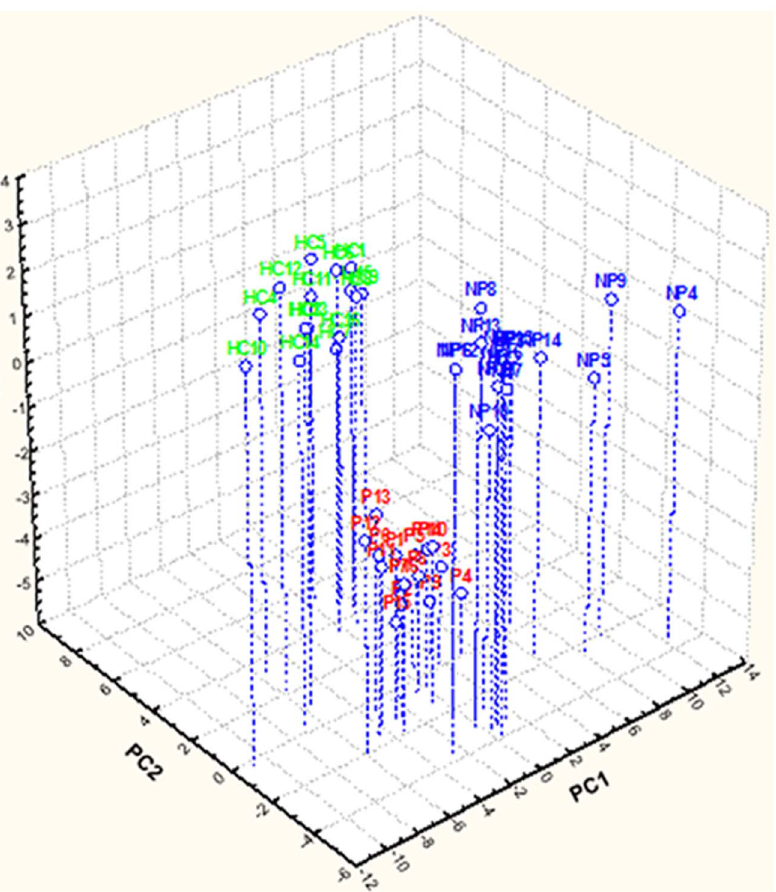
Figure 5. Principal component analysis (PCA) of active bacterial genera found in feces of subjects. Score plot of the three principal components (PC) after principal component analysis (PCA) of metabolically active bacterial genera (16S rRNA), which were found in the fecal samples of immunoglobulin A nephropathy (IgAN) non progressor (NP) and progressor (P) patients, and healthy controls (HC). 1–16, number of fecal samples for each group of subjects.